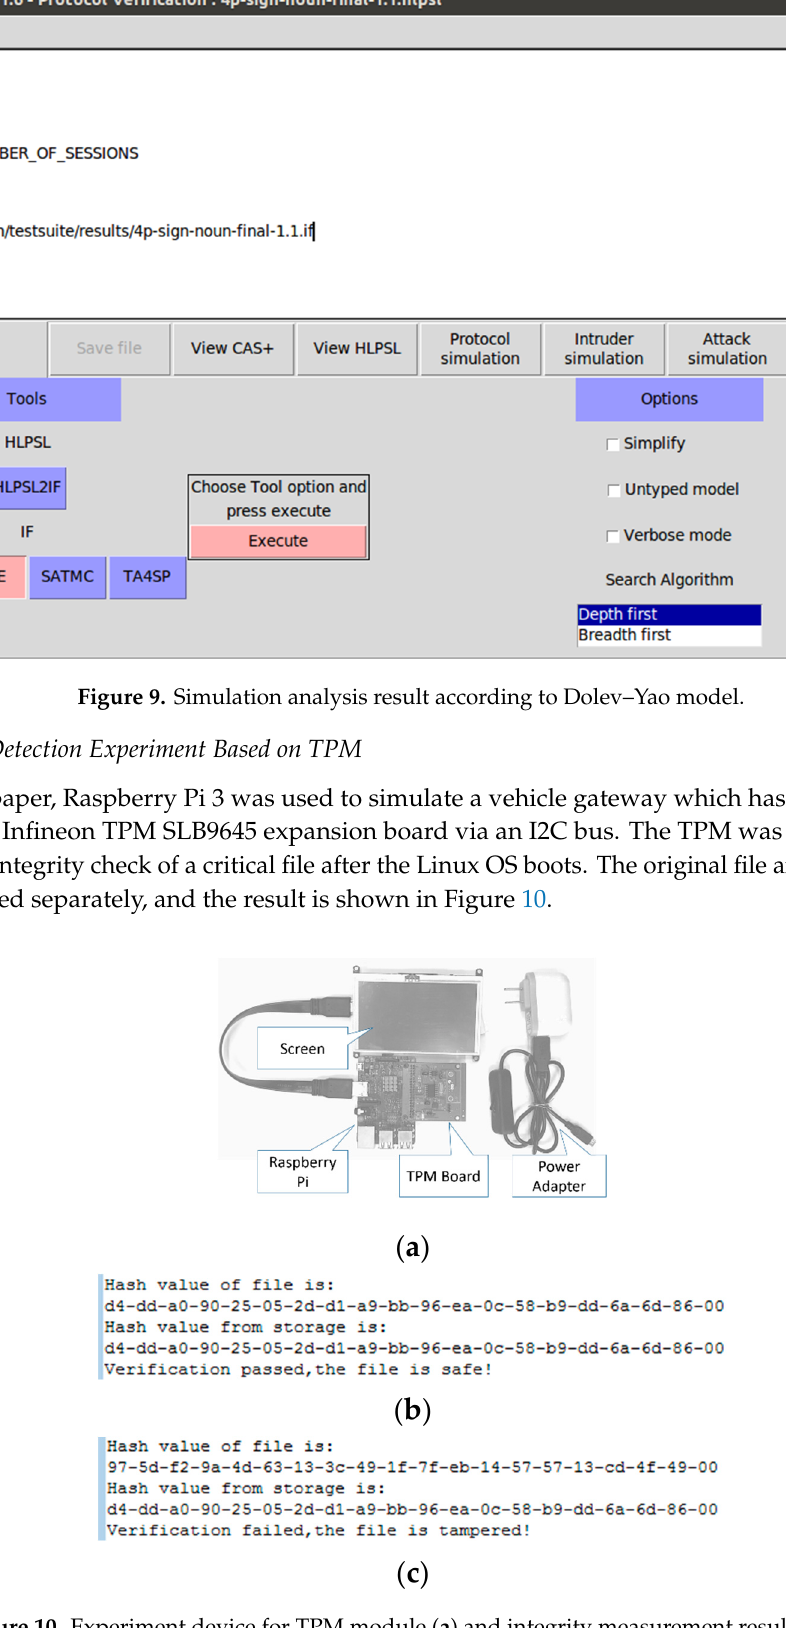
Figure 8. Environment and goal definitions in HLPSL under SPAN software [22].